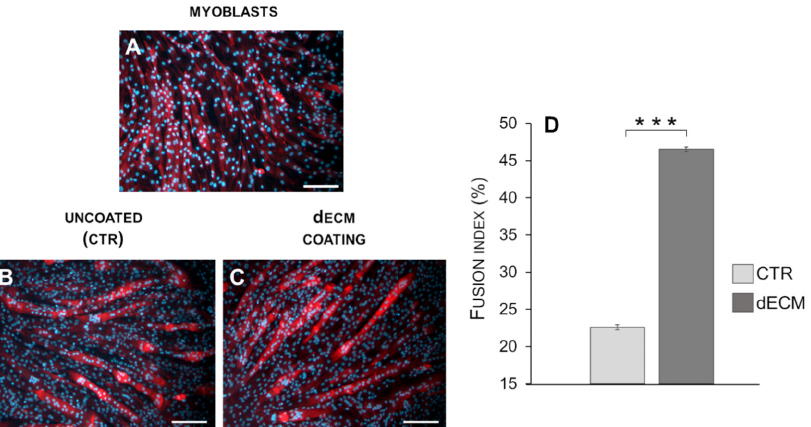
Figure 7. Fluorescence analysis of myotubes induced to differentiate in low serum medium in plates either uncoated (( B ): CTR) or coated ( C ) with dECM. Cells at day 9 post differentiation were stained with phalloidin (red fluorescence) to high- light cytoplasm and with DAPI (blue fluorescence) to depict nuclei. Undifferentiated myoblasts were used as control ( A ). dECM coating induces fusion of C2C12 myotubes, as shown by the fusion index taken 9 days post-differentiation ( D ). Statistic was determined by t -test, *** p < 0.001. Scale bars: 200 µm.